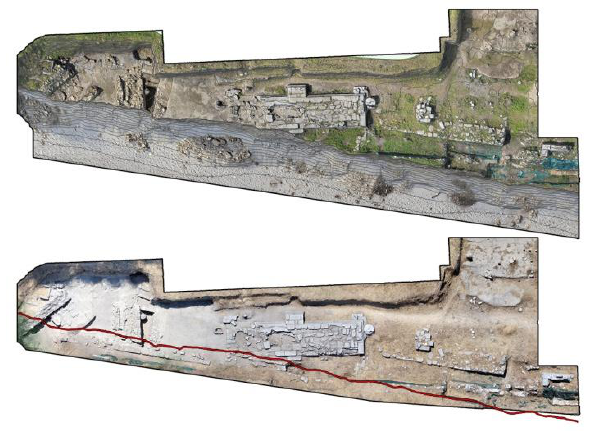
Figure 13: Orthophotos of the southern sector before (below) and after the seastorm. The red line indicates the current edge of the natural